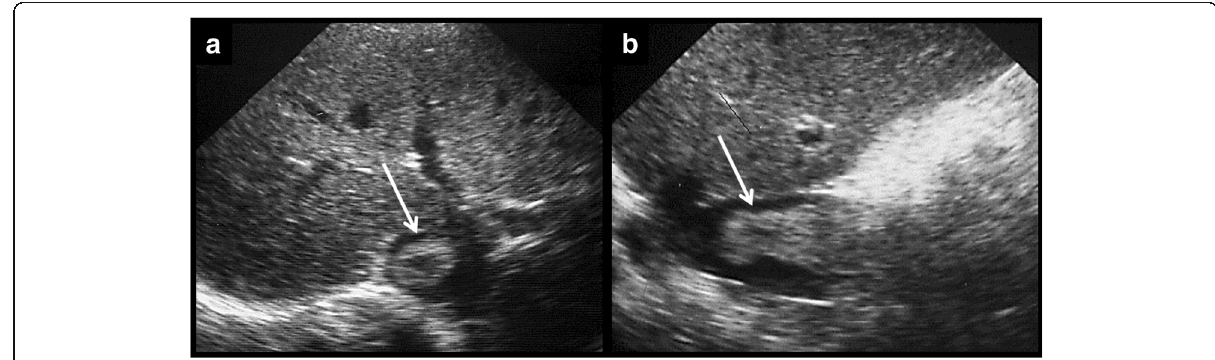
Fig. 12 a , b Thrombosis of the inferior vena cava. Thrombosis of the inferior vena cava was discovered through an axial ultrasound examination. Sagittal examination helps to asses its